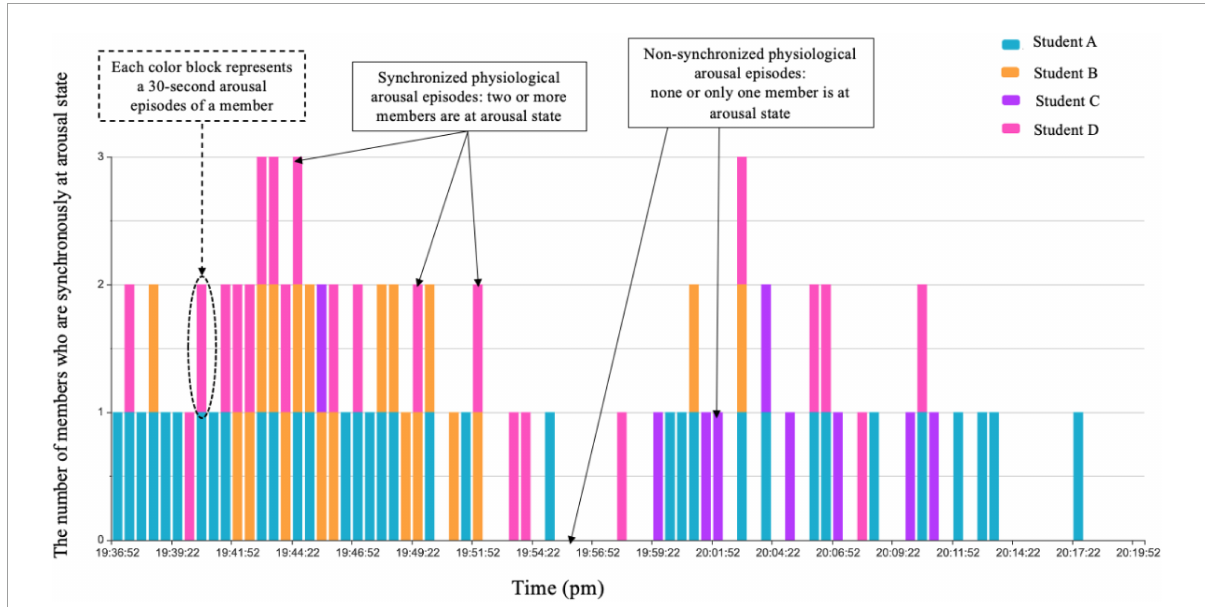
FIGURE4 Identifying synchronized physiological arousal episodes within a group based on timeline [group 4 had four members and engaged in collaborative argumentation (CA) from 19:36:52 to 20:23:22 p.m. The x -axis represents time, and the y -axis represents the number of members who are synchronously in an arousal state. The episodes with superimposed color blocks are the synchronized physiological arousal episodes].